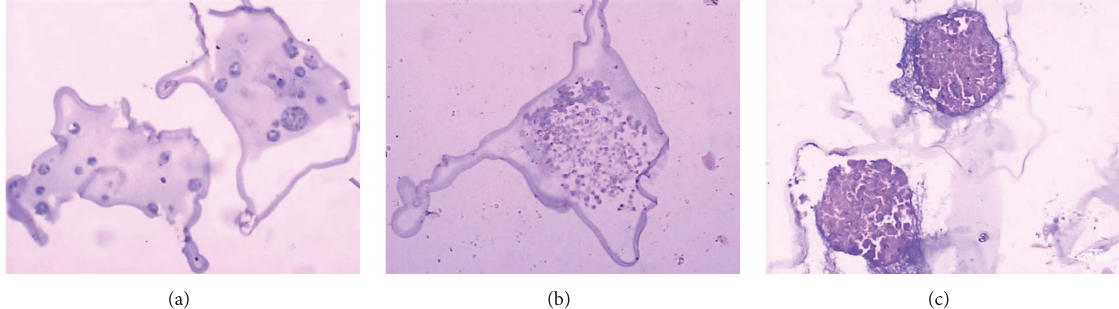
Figure 4: Proliferation of microencapsulated SGC9701 cells by BrdU staining. Brown or yellow nuclear staining indicates live cells. After culturing for (a) 7 days or (b) 14 days, the cells tended to aggregate into spheres. The entire microencapsulated spheres showed positive BrdU staining. (c) After 21 days, the staining color faded or the center of the cells showed no staining while the cells outside still showed staining.